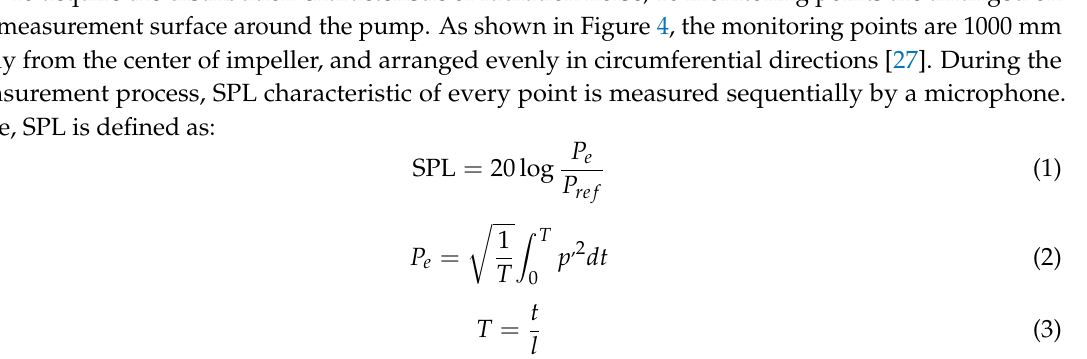
Figure 3. Structure diagram of measurement system.